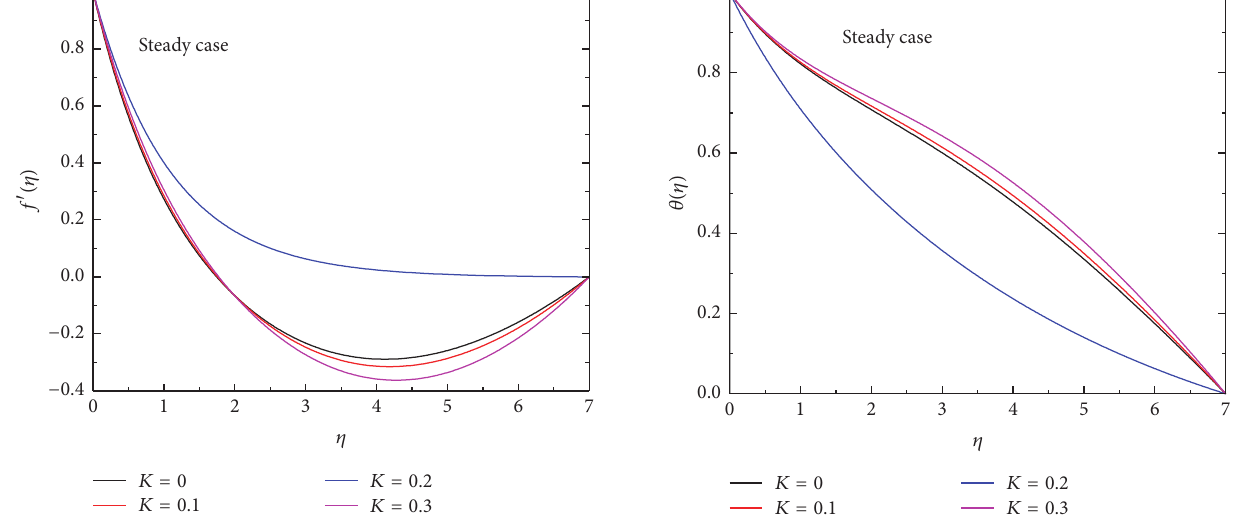
0.2K = K = Figure 5: Velocity profiles for various values of 𝐾 when 𝐴 = 0.4 , 𝑅 = 0.5 , and 𝜉 = 0 .